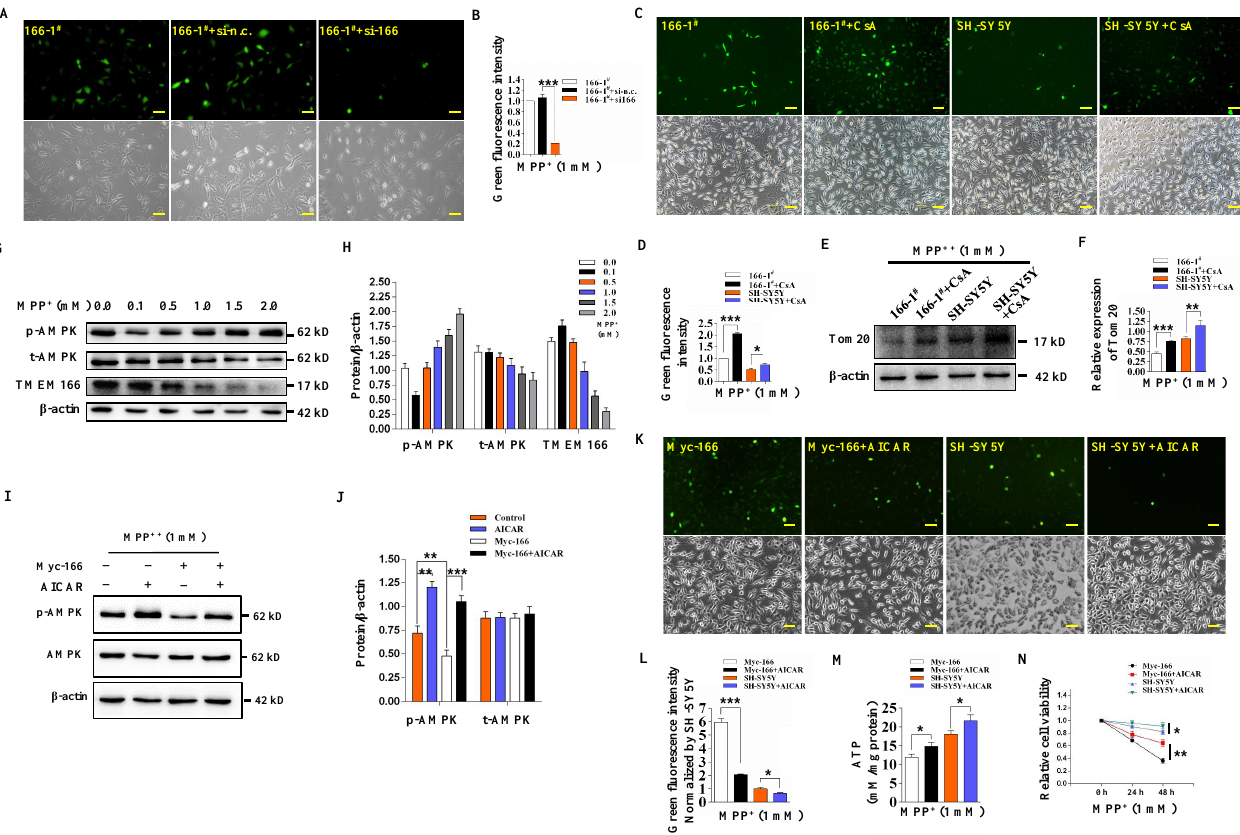
Figure 5. Overexpressed TMEM166 aggravates MPP + -induced oxidative stress by inhibiting AMPK activation independent of mitophagy promotion. ( A ) 166-1 # cells after knocking down TMEM166 were exposed to MPP + for 24 h and then ROS production was detected. Scale bars, 50 µ m. ( B ) Quantification analysis of the ROS fluorescence intensity with ImageJ v1.53 k. Data were normal- ized to the 166-1 # control. ( C , E ) 166-1 # cells and SH-SY5Y cells were pretreated with 0.4 µ M CsA for